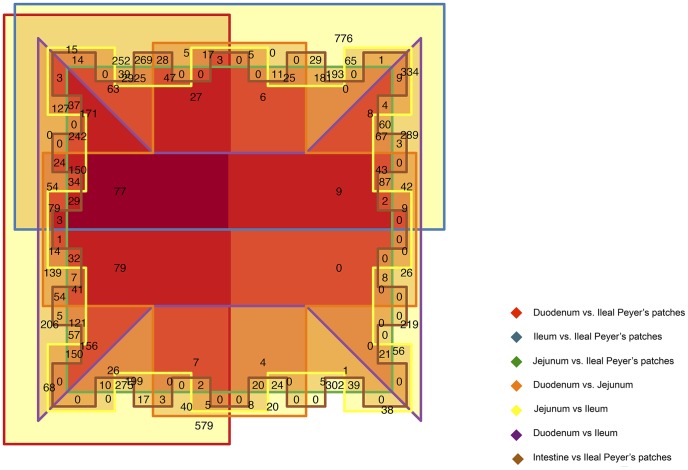
Euler diagram of ubiquitously differentially expressed genes between tissues.Euler diagram was implemented through the VennDiagram package in the R statistical environment.